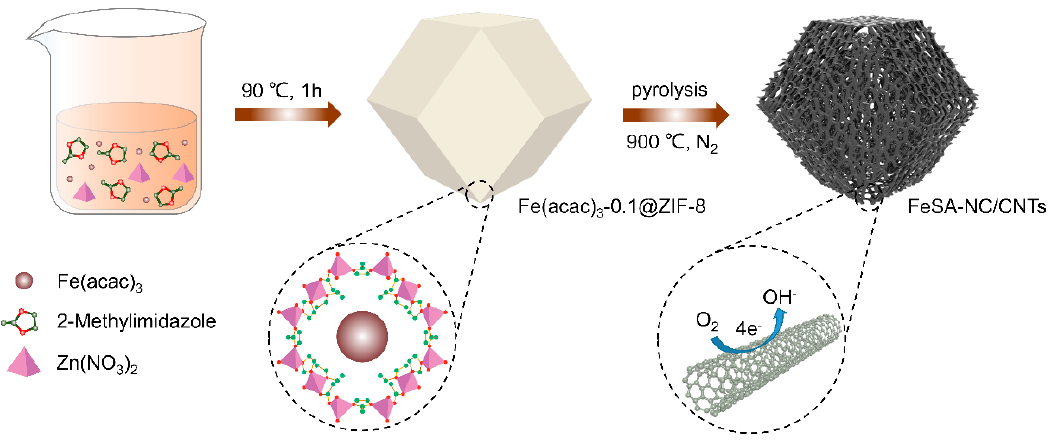
Figure 1. The schematic illustration of FeSA-NC/CNTs.